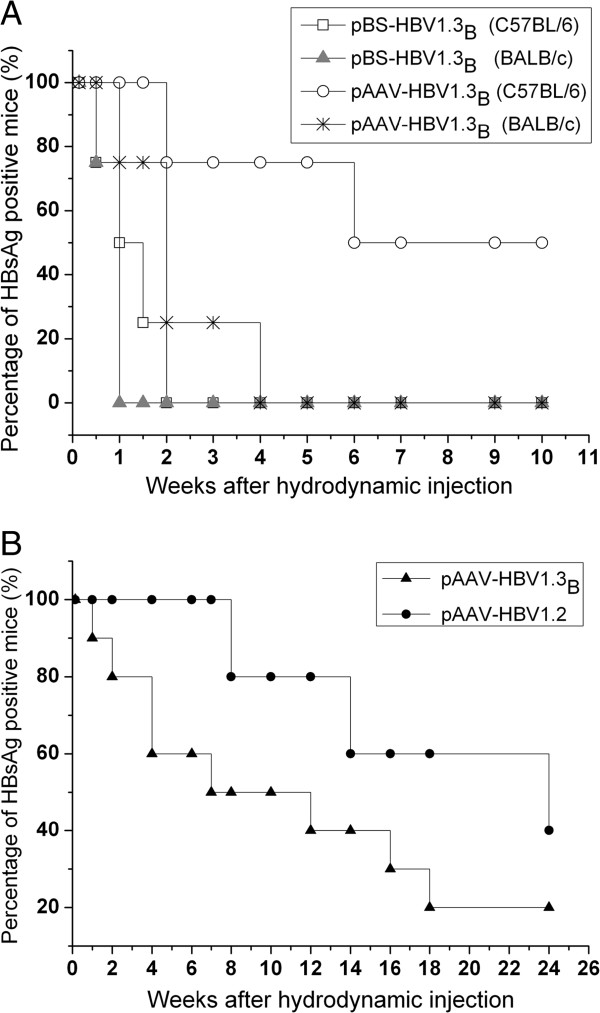
HBV persistence after HI in mouse in dependence on the mouse genetic backgrounds and the vector backbones. 10 μg of pBS-HBV1.3B or pAAV-HBV1.3B were injected into the tail veins of BALB/c or C57BL/6 mice. Each group included 5 mice. In addition, 10 μg pAAV-HBV1.3B or pAAV-HBV1.2 were injected into the tail veins of C57BL/6 mice to test the ability of these two plasmids to establish persistent HBV replication. pAAV-HBV1.3B group included 14 mice and pAAV-HBV1.2 group included 9 mice. (A) The positive rate for serum HBsAg in C57BL/6 or BALB/c mice receiving pBS-HBV1.3B or pAAV-HBV1.3B injections at indicated time points after injection. The data were analyzed by Kaplan–Meier analysis, and the differences between each group were statistically significant (p = 0.004, <0.05). (B) The positive rate for serum HBsAg in C57BL/6 mice receiving pAAV-HBV1.3B or pAAV-HBV1.2 injection. The data were analyzed by Kaplan–Meier analysis, and the differences between two groups were statistically significant (p = 0.017, <0.05). The cutoff value for determining HBsAg-positivity was 0.1.